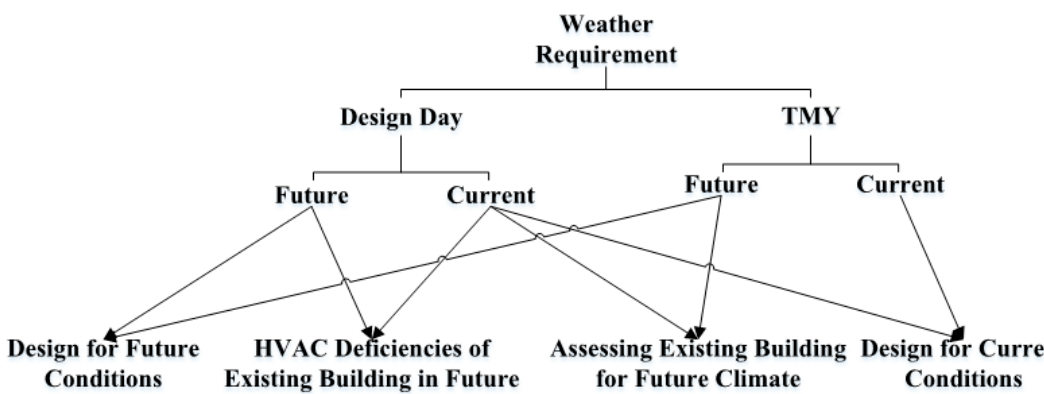
Figure 3. Approach to assess building energy demand and consumption using DD and TMY files.